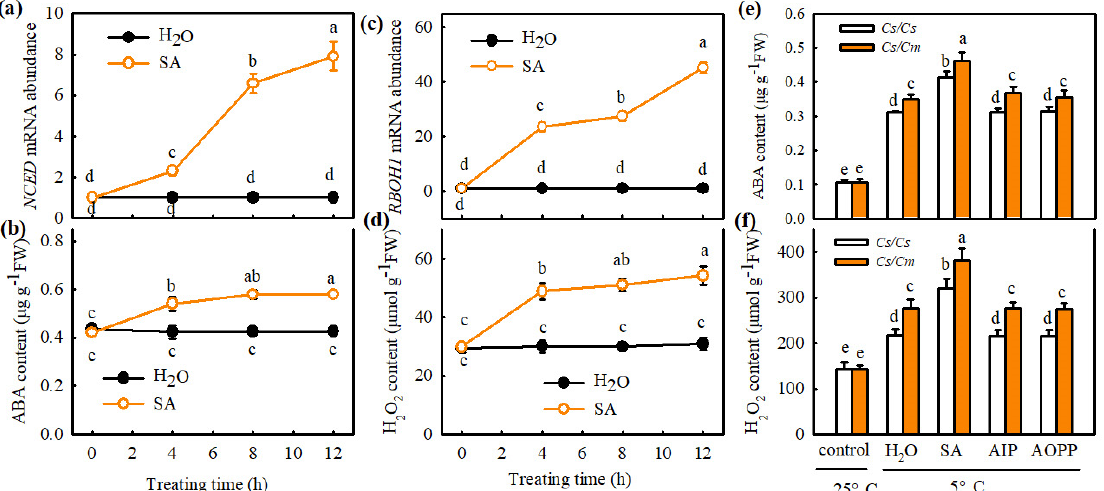
Figure 4. SA is involved in grafting-induced accumulation of ABA and H 2 O 2 in cucumber leaves. ( a , b ) Changes of NCED mRNA abundance and ABA content in Cs/Cs , respectively, at 25 °C. ( c , d ) Changes of RBOH1 mRNA abundance and H 2 O 2 content in Cs/Cs , respectively, at 25 °C. Plants with three leaves were pretreated with 1.0 mM SA or distilled water (control) for 12 h. ( e , f ) ABA and H 2 O 2 contents in Cs/Cs and Cs/Cm leaves, respectively, before and after exposure 5 °C for 24 h. Plants were pretreated with 1.0 mM SA, 30 μ M AIP, 0.1 mM AOPP (two biosynthetic inhibitors of SA), or deionized water (control), respectively, for 12 h and then exposed to chilling stress. Data are presented as the means ± SD ( n = 3). Different letters indicate a statistical significance between samples at p < 0.05.